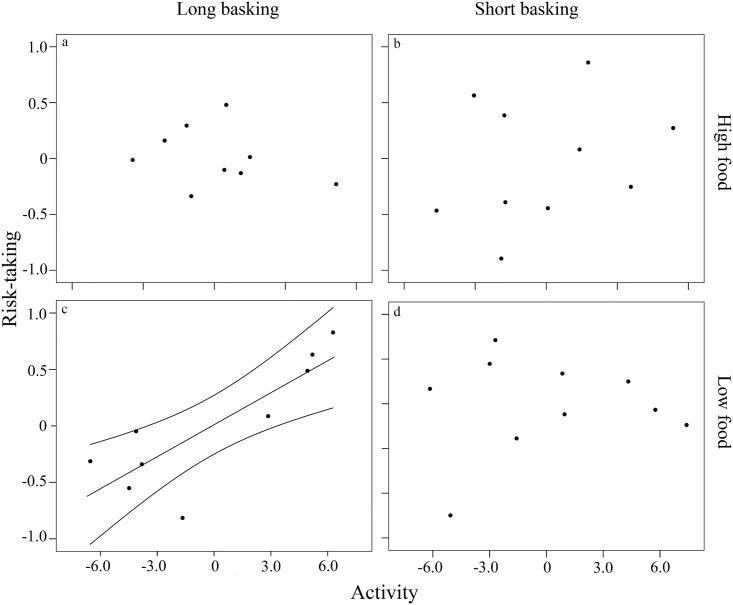
Between-individual correlation of risk-taking and activity in adult male European green lizards (Lacerta viridis) in the a) high food × long basking time (nonsignificant), b) high food × short basking time (nonsignificant), c) low food × long basking time (significant), and d) low food × short basking time (nonsignificant) groups.Risk-taking and activity are represented by best linear unbiased predictors (BLUPs) extracted from bivariate mixed models. Risk-taking is represented by a latency variable that was multiplied by -1 for straightforward interpretation; hence, small values translate to low risk-taking in the figure. Regression line is shown only for significant relationships.